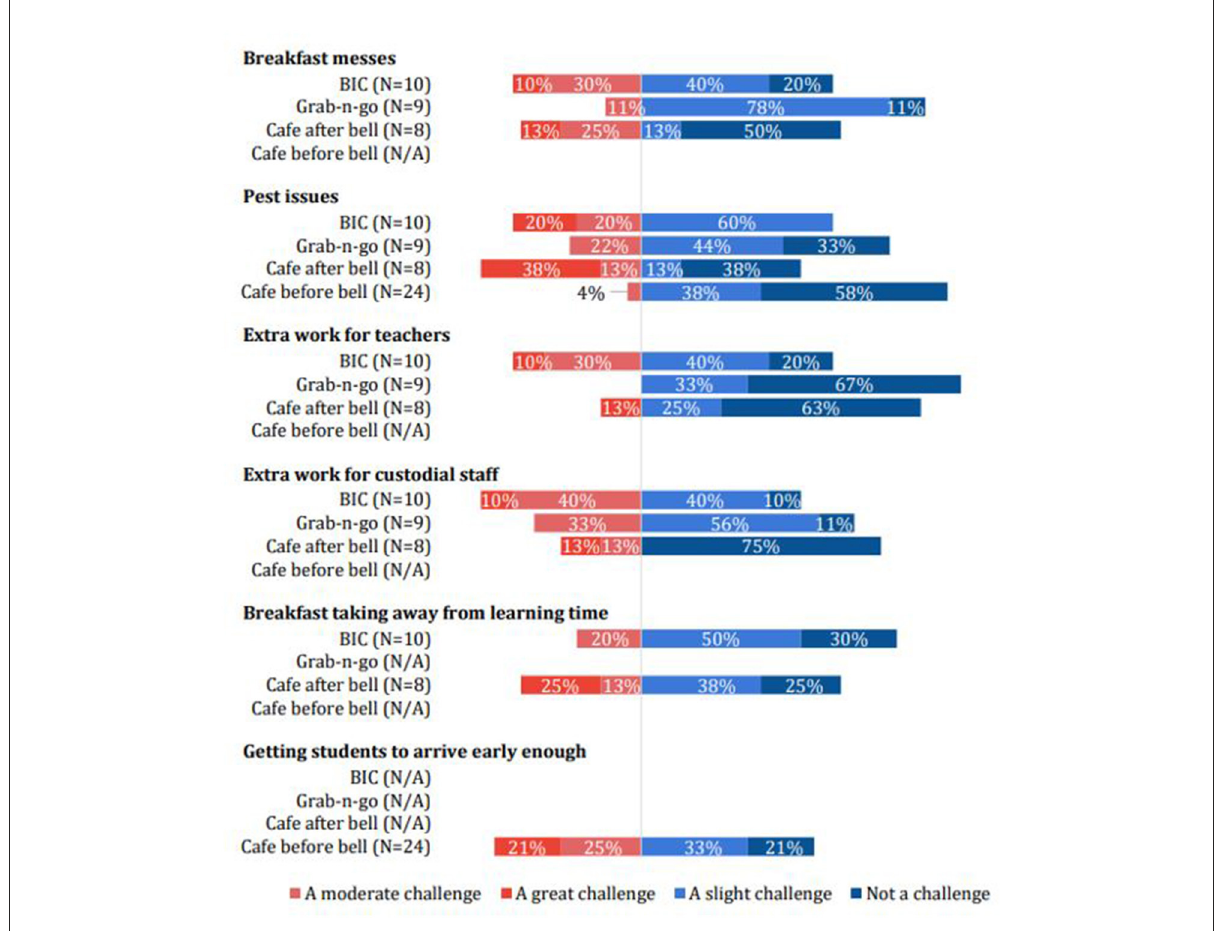
FIGURE3 Principal-reported negative implementation determinants according to breakfast